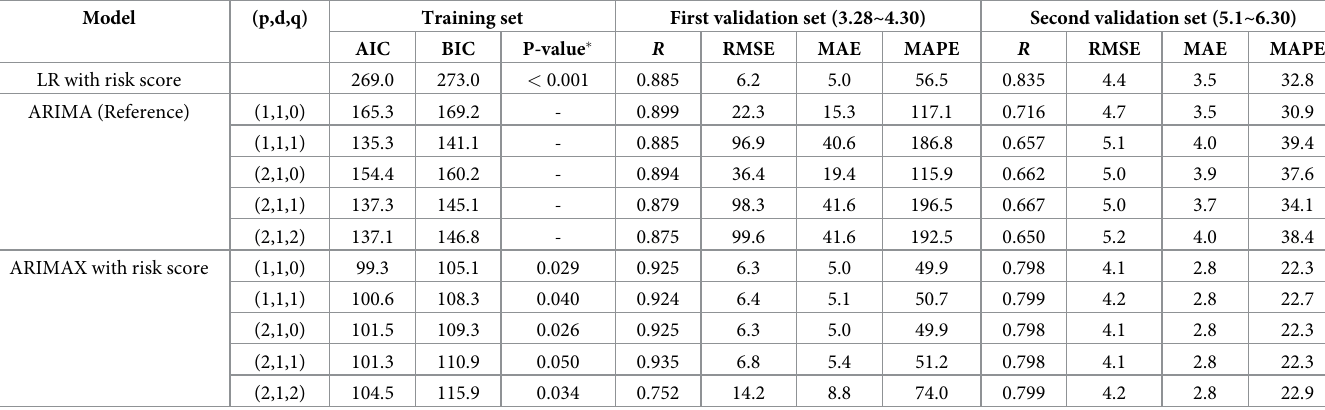
Table 1. Performance of the forecasting models for imported COVID-19 cases after 12 days. Model